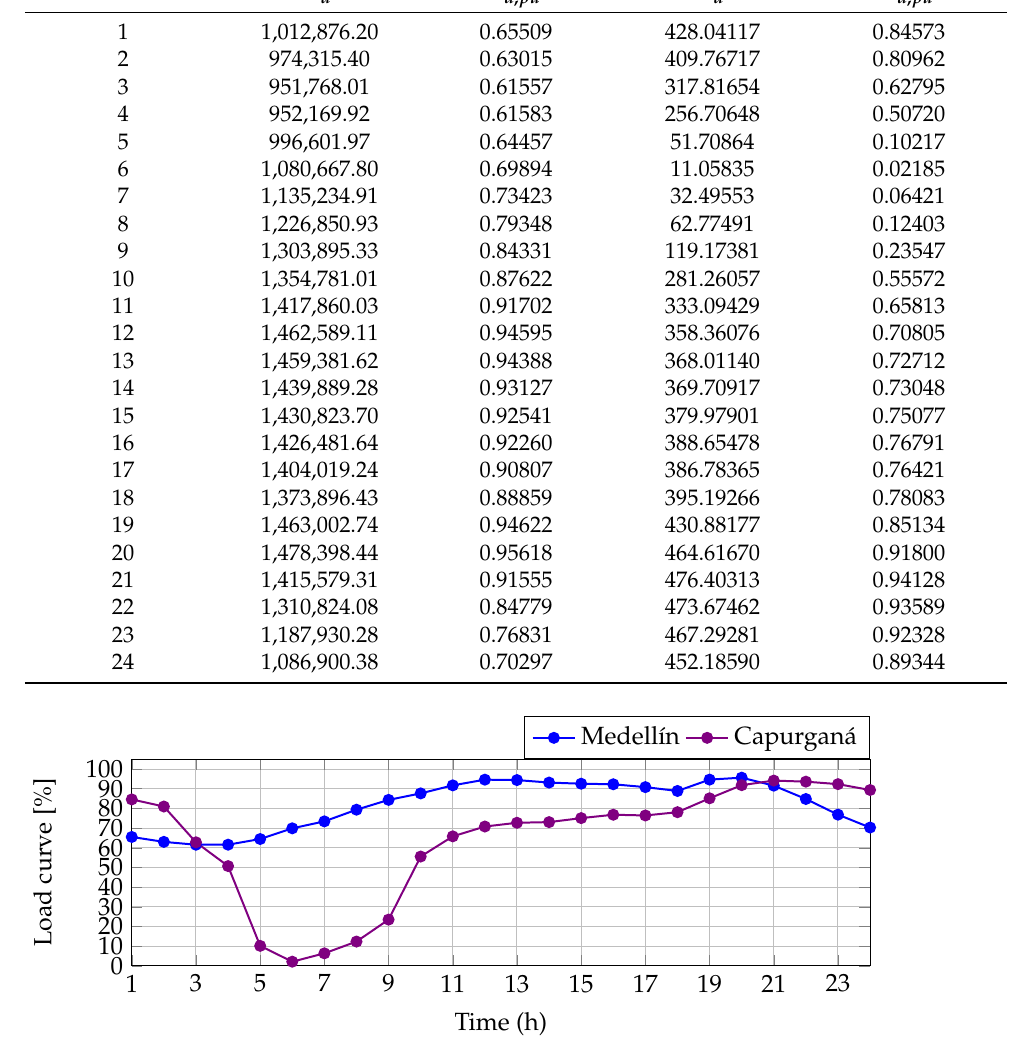
Figure 4. Expected energy consumption profiles for Medellín and Capurganá,